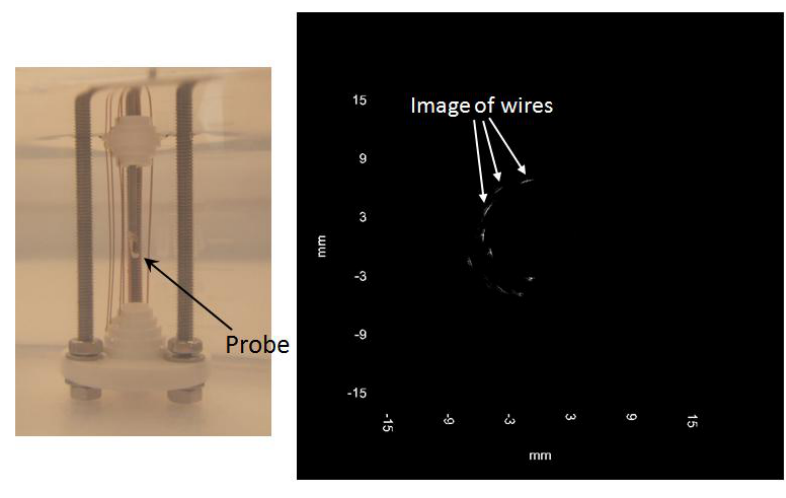
Figure 5. Photograph of the wire phantom and wire phantom image captured by the 10 MHz endoscopic